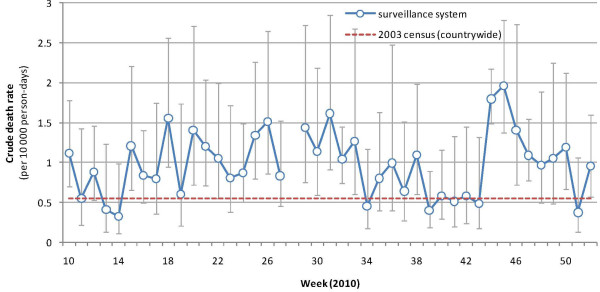
Crude death rate by week, 2010. Vertical bars represent 95% CIs. The crude death rate estimated for CAR as a whole in the 2003 census is also shown as reference.